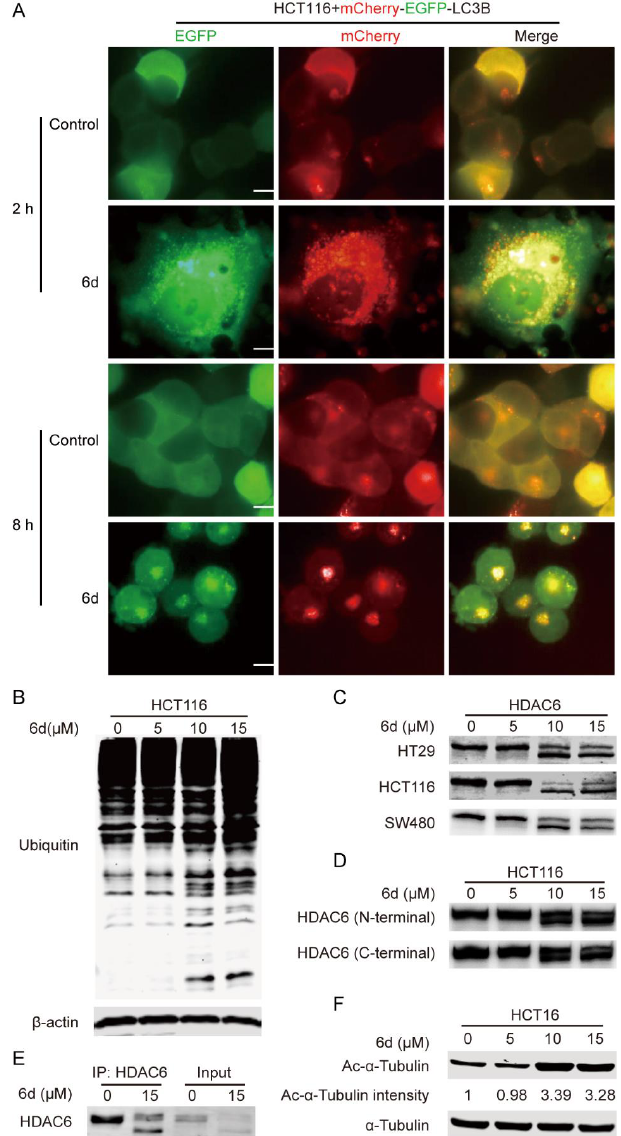
Figure 4. HDAC6 cleavage induced by compound 6d influences its deacetylase activity, autophagic flux and ubiquitinated protein degradation. ( A ) The tandem mCherry-GFP tagged LC3B pH-based autophagy reporter system was used to analyze the effect of compound 6d on autophagic flux. Autophagosomes appear as yellow puncta (both mCherry and GFP signals), while autophagolysosomes appear as red puncta (mCherry-only signals). Fluorescent images of mCherry-GFP-LC3B puncta in HCT116 cells treated with compound 6d were captured by an opera ® high-throughput confocal imaging platform. Scale bar, 10 μm. ( B ) Compound 6d promotes the accumulation of ubiquitinated proteins in a dose-dependent manner. β-actin level was used as internal control for equal protein loading. ( C ) Compound 6d induces the cleavage of HDAC6 in CRC cells. Lysates were harvested from HT29, HCT116, and SW480 cells after exposure to the indicated concentrations of compound 6d , and then subjected to WB with antibody against the N-terminal (1–100 aa) of HDAC6. ( D ) Both the antibodies against N- or C-terminal of HDAC6 are capable of recognizing the cleaved fragments induced by compound 6d . ( E ) IP with antibody against the N-terminal of HDAC6 confirms the HDAC6 cleavage triggered by compound 6d in HCT116 cells. ( F ) The acetylation of α -tubulin was significantly elevated in a dose-dependent manner in HCT116 cells treated with compound 6d